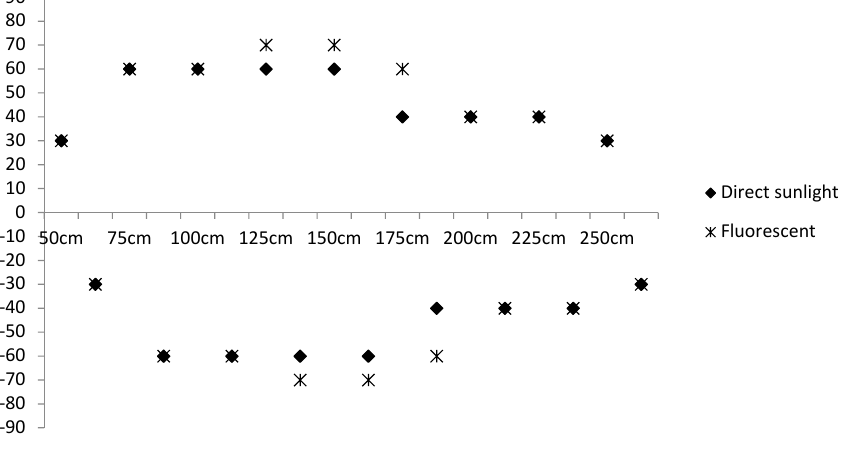
Figure 13. The accuracy of QR code detection in terms of the maximum detection distance (MDD) and